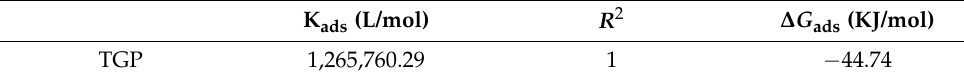
Table 4. Adsorption parameters of the TGP for MS in 0.5 M H 2 SO 4 at 298